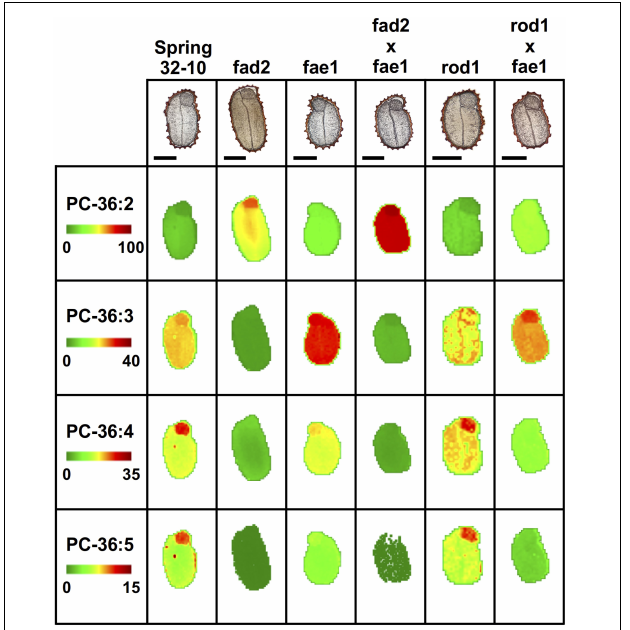
FIGURE 5 | Mass spectrometry (MS) imaging of selected phosphatidylcholine (PC) molecular species in wild-type and CRISPR mutant T. arvense seeds. MS images are presented as false colored images with each pixel representing an individual scan rastered over the imaged seed section (microscopy image above, scale bar = 500 µ m). The color intensity scale ranges from green (low) to red (high) as the mol% value of the metabolite class. Each row of images are set to the same mol% scale to show relative differences in abundance and localization between each seed